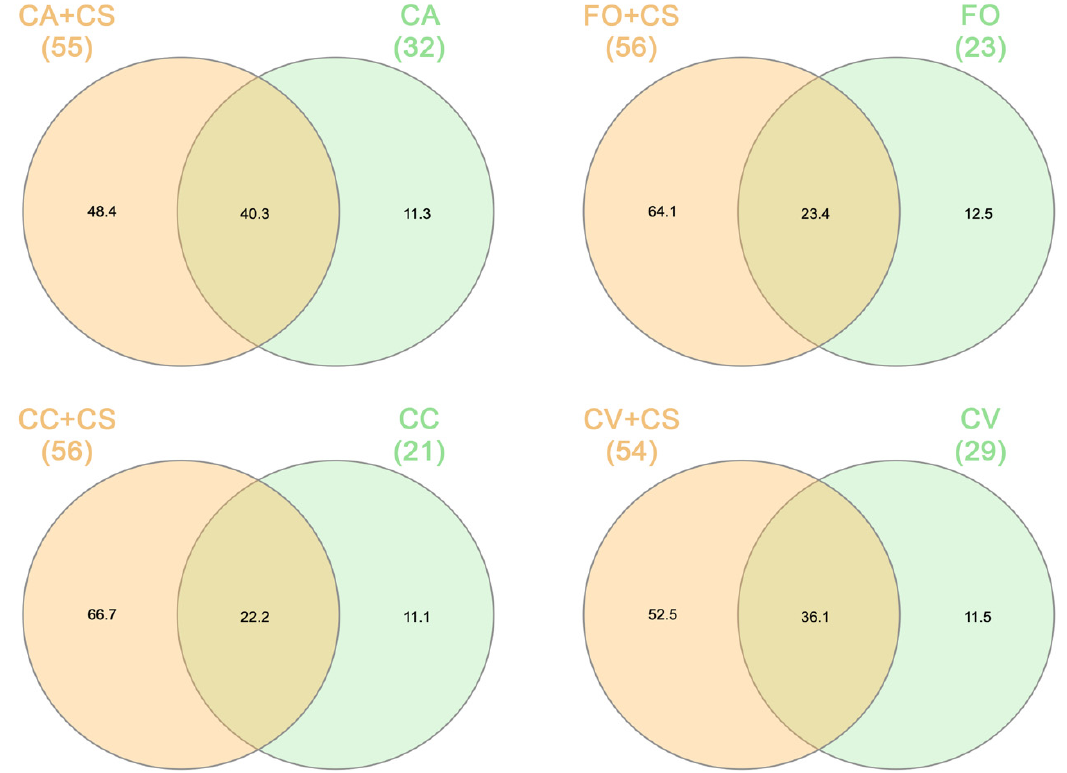
Figure 4. VENN diagram obtained by the VOC profiles comparison between the 4 rootstocks (CA, CC, CV, and FO) previously studied by Guarino et al. 2021 [16] and the compounds recorded in the C. sinensis grafted on the same 4 specific rootstocks investigated here (CA + CS, CC + CS, CV + CS, and FO + CS). The number of compounds extracted from each rootstock and combination was reported in bracket.